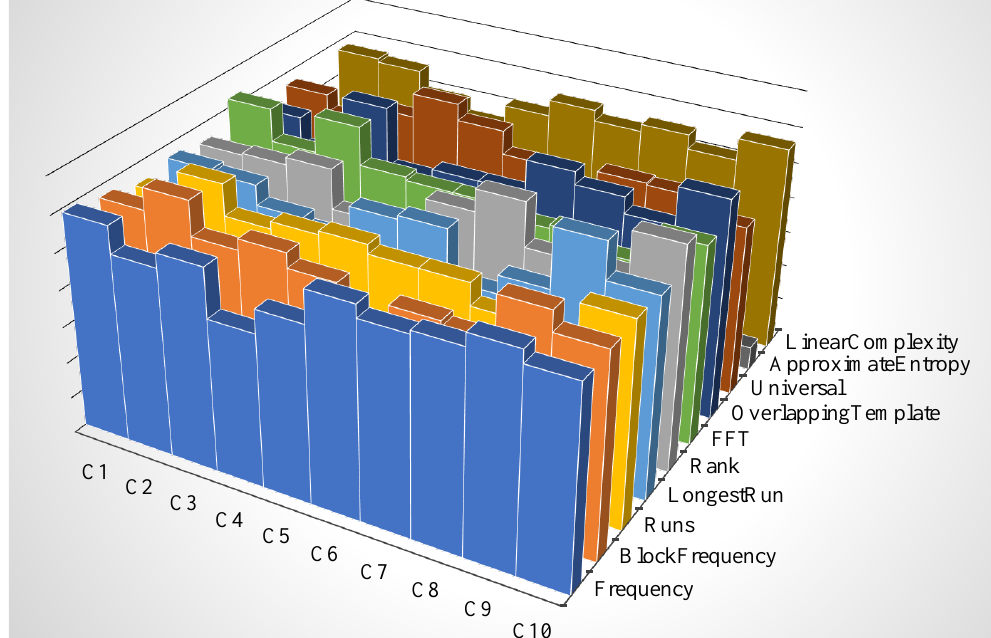
Figure 9. Histograms of the p-values’ distributions. The (three-dimensional) histograms